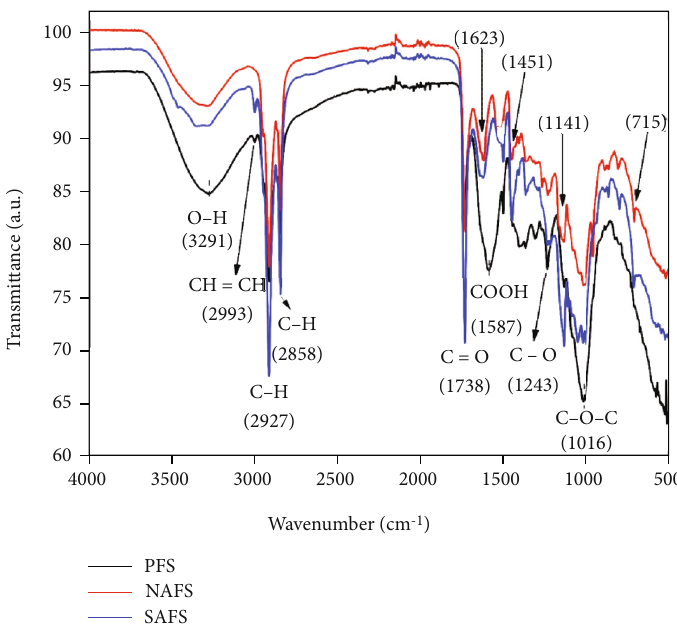
Figure 3: FTIR spectra of pure (PFS) and treated (NAFS and SAFS) fennel seed adsorbents.